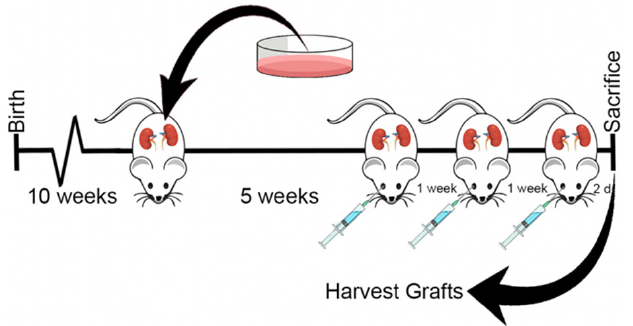
Figure 6. Treatment outline for PC3 and LNCaP tumor-bearing nude mice. Harvested PC3 and LNCaP prostate cancer cells were implanted under the kidney capsules of 10-week-old mice (one cell line on each kidney) and allowed to grow for five weeks. Mice were dosed retro-orbitally with vehicle (saline), Taxotere ® (15 mg/kg), or o(LA) 8 -DTX (50%) (25 mg/kg DTX-equivalent) once-weekly for three weeks. Two days following last treatment, mice were euthanized, and tumors were harvested for IHC analysis.